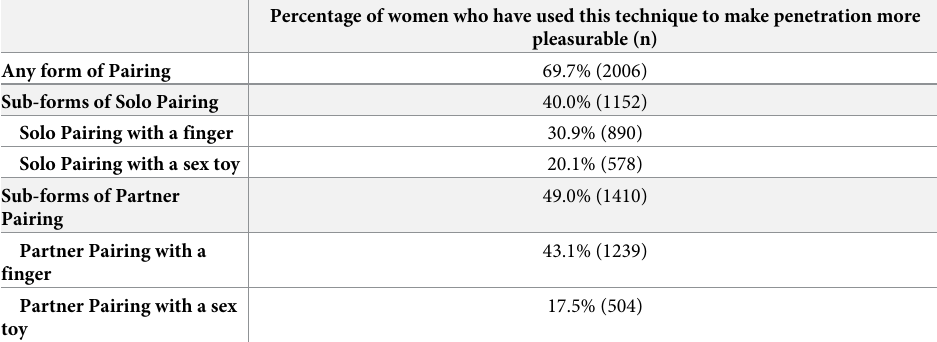
Table 6. Prevalence of use of Pairing techniques by women to make vaginal penetration more pleasurable (N = 2877, weighted). Percentage of women who have used this technique to make penetration more pleasurable